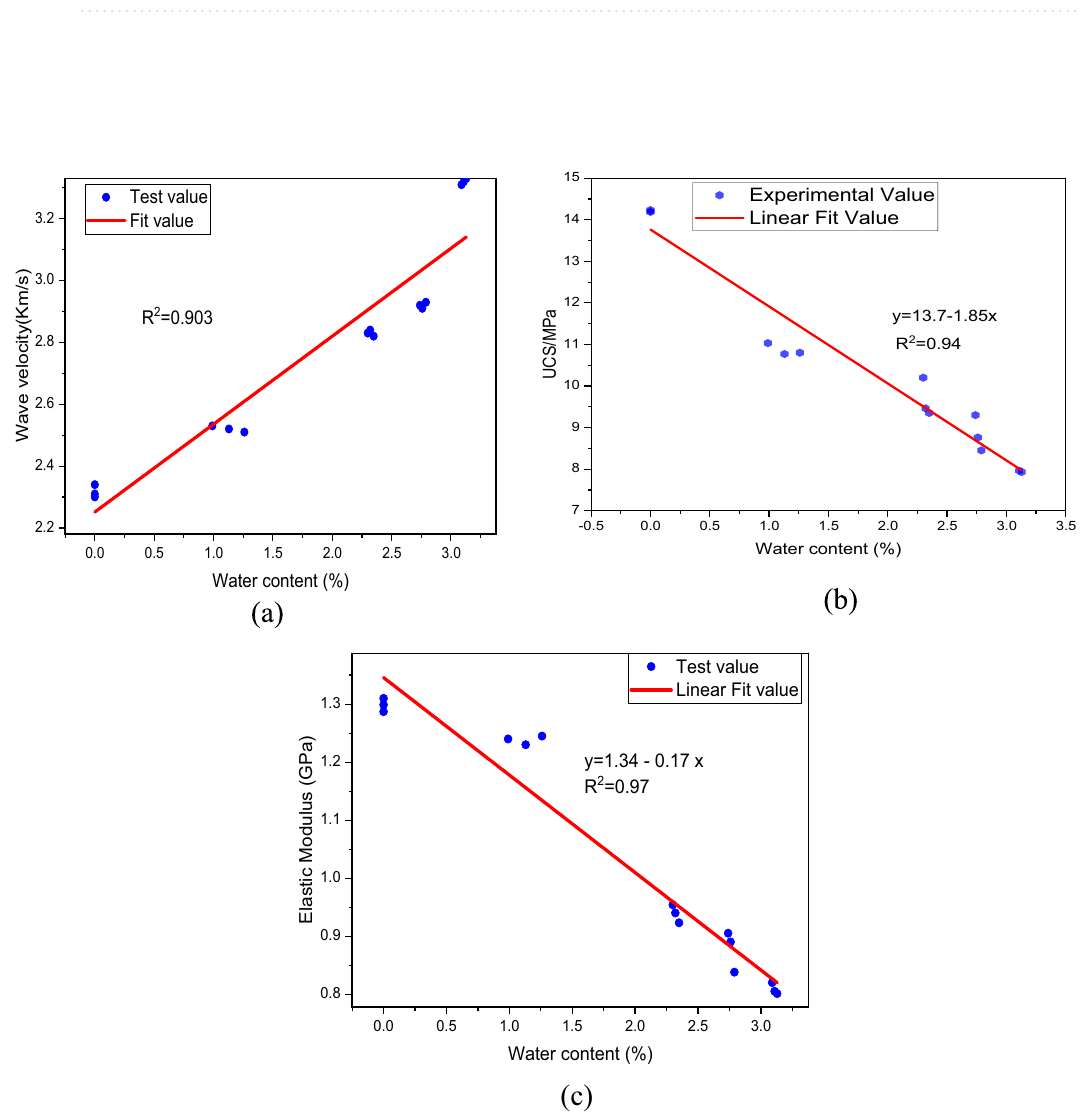
Figure 6. Properties of coal with different soaking time ( a ) wave velocity, ( b ) UCS, ( c ) elastic